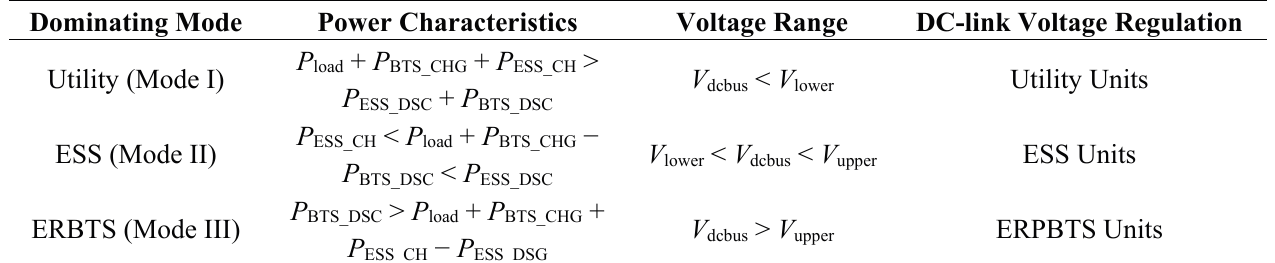
Table 1. Energy optimal scheme for hybrid AC-DC microgrid.